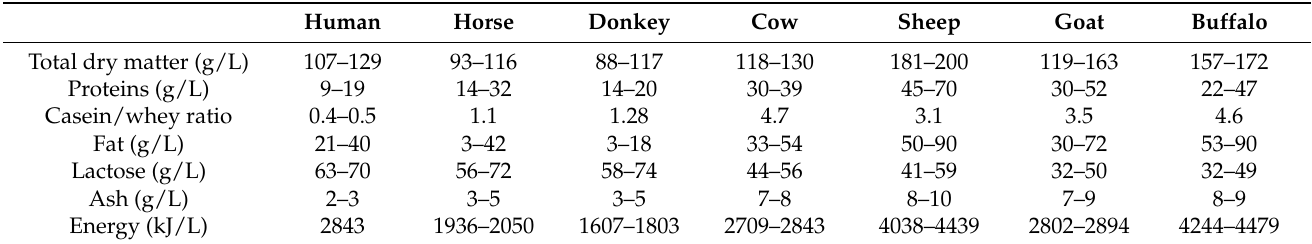
Table 1. Milk composition for different species (adapted from